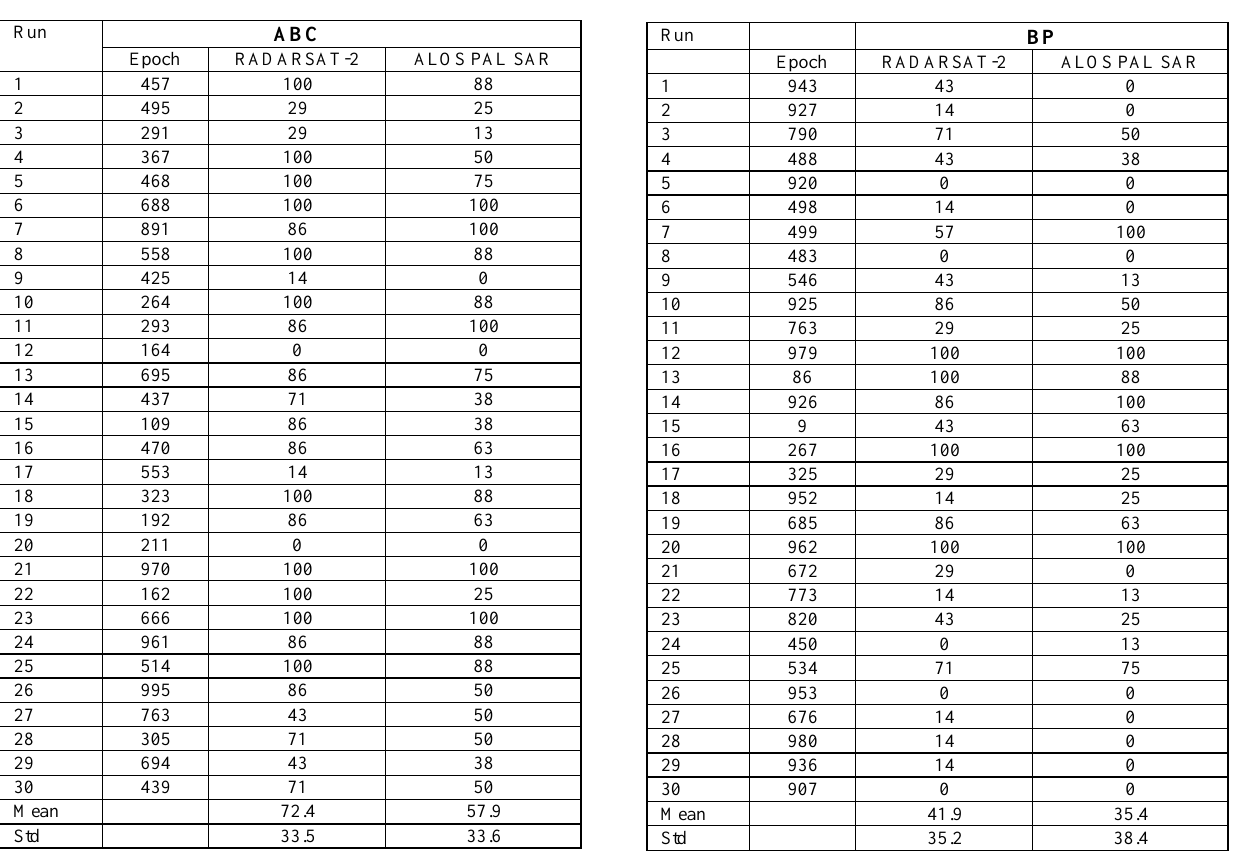
Table 4. Classification accuracies of ABC, LM and BP through optimum